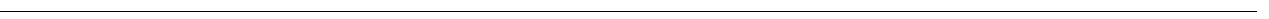
Fig. 1 Itch ubiquitylates and binds SuFu. a , b HEK293T cells were transfected with plasmids expressing HA-ubiquitin (HA-Ub) in the presence of different E3 ubiquitin ligases ( a ) or increasing amount of Flag-Itch ( b ). Cell lysates were immunoprecipitated with an anti-SuFu antibody, and ubiquitylated forms were revealed with an anti-HA antibody. c HEK293T cells were co-transfected with Flag-Itch and HA-SuFu as indicated. Interaction between Itch and SuFu was detected by immunoprecipitation (IP) followed by immunoblot (IB) analysis with the indicated antibodies. d Interaction between endogenous Itch and SuFu was detected in HEK293T cells by immunoprecipitation followed by immunoblot analysis with the indicated antibodies. e GST-Itch was bound to glutathione-sepharose beads and used for in vitro pull-down assay. In vitro translated 35 S-labelled SuFu was incubated with free GST control or GST-Itch. After GST pull-down, the protein complex was detected by fl uorography. Coomassie blue staining shows the expression levels of recombinant proteins GST-Itch or GST only. f GST-SuFu was bound to glutathione-sepharose beads and used for in vitro pull-down assay. Untagged Itch recombinant protein was incubated with free GST control or GST-SuFu. After GST pull-down, the protein – protein interaction was detected by IB with an anti-Itch antibody. Coomassie blue staining shows the expression levels of recombinant proteins GST-SuFu or GST only. g Schematic representation of Itch and its interaction with SuFu. h , i GST-HECT ( h ) or GST-4WWs ( i ) were bound to glutathione-sepharose beads and used for in vitro pull-down assay with in vitro translated 35 S-labelled SuFu. After GST pull-down, protein complexes were analysed by IB. j A GST pull-down assay with GST-WW1, -WW2, -WW3, or -WW4